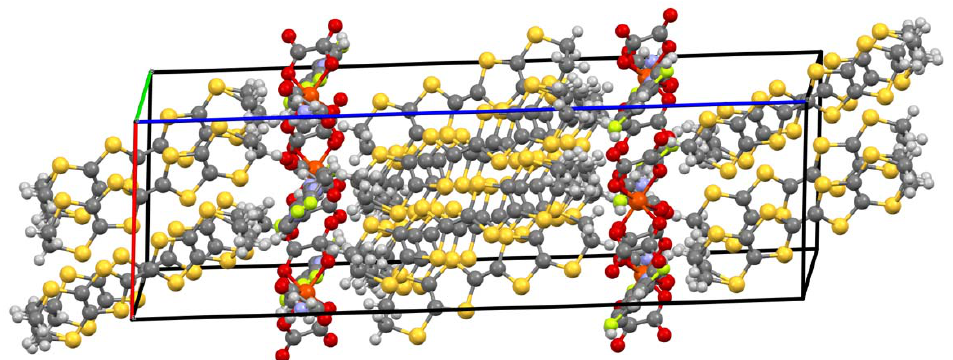
Figure 1. Crystal structure of salt 2 β ″ -(BEDT-TTF) 4 (NH 4 )[Fe(C 2 O 4 ) 3 ](2,3-DFPy; the other salts are isostructural. Carbon is dark gray, hydrogen is light gray, sulfur is yellow, oxygen is red, nitrogen is light blue, fluorine is light green, and iron is orange.